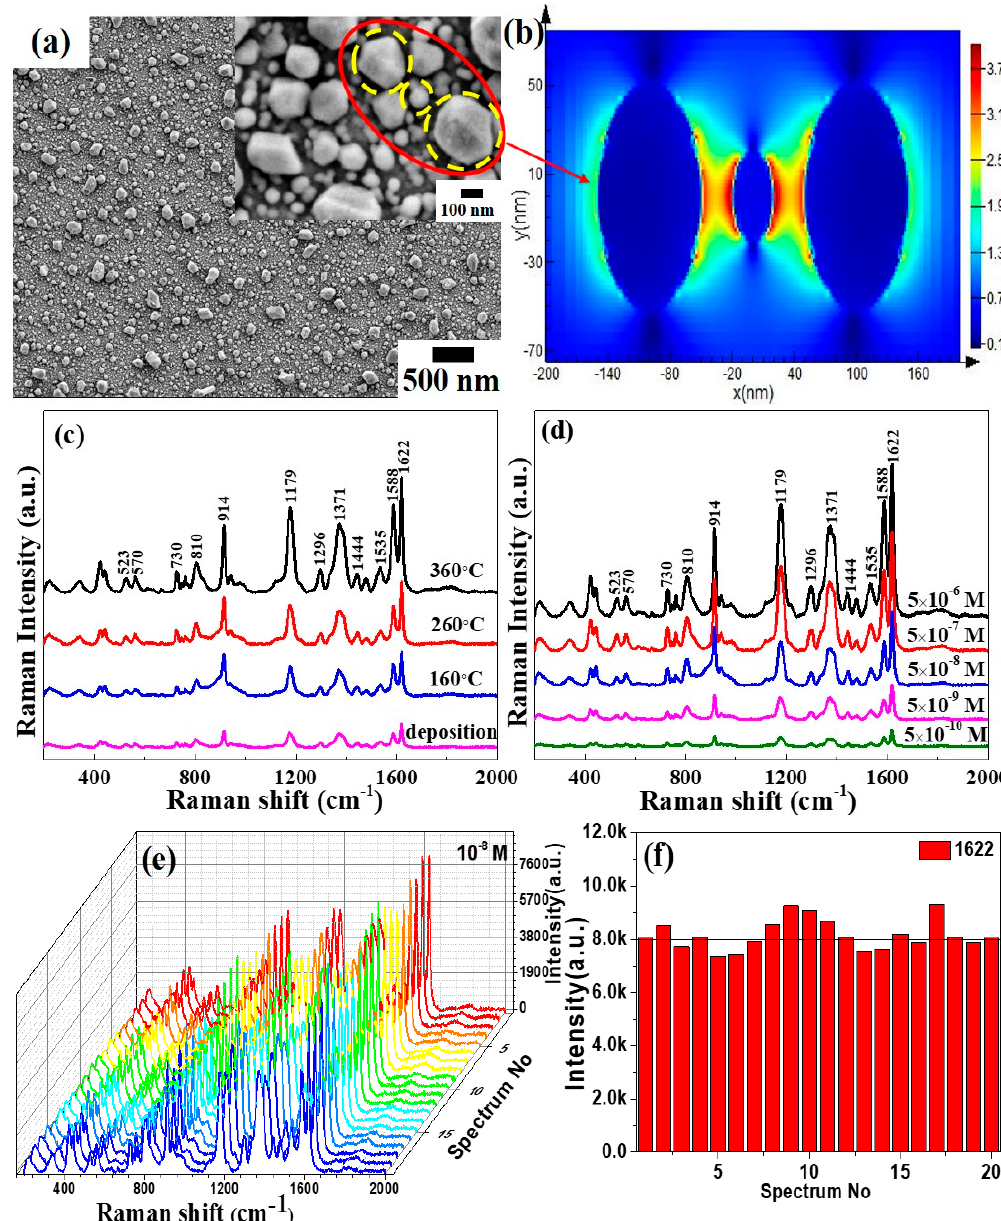
Figure 5. ( a ) SEM image of the Ag layer/Mo-48.2% Ag films annealed at 360 °C; ( b ) finite-difference time-domain (FDTD) simulations of the EM field intensity in the red circle region of Figure ( a ); ( c ) SERS spectra of the Ag layer/Mo-48.2% Ag films with different annealing temperatures; ( d ) SERS spectra of the Ag layer/Mo-48.2% Ag films annealed at 360 °C in different concentrations of CV solution; ( e ) SERS spectra of 20 randomly selected locations in the Ag layer/Mo-48.2% Ag films annealed at 360 °C; ( f ) variation of the Raman spectra intensity at 1622 cm − 1 peaks in ( e ).